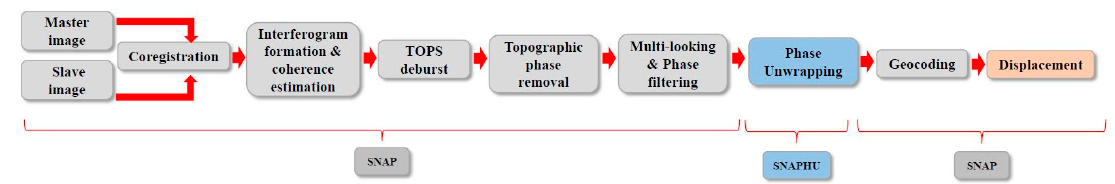
Figure 2. Methodology for the estimation of subsidence in the mining sector.